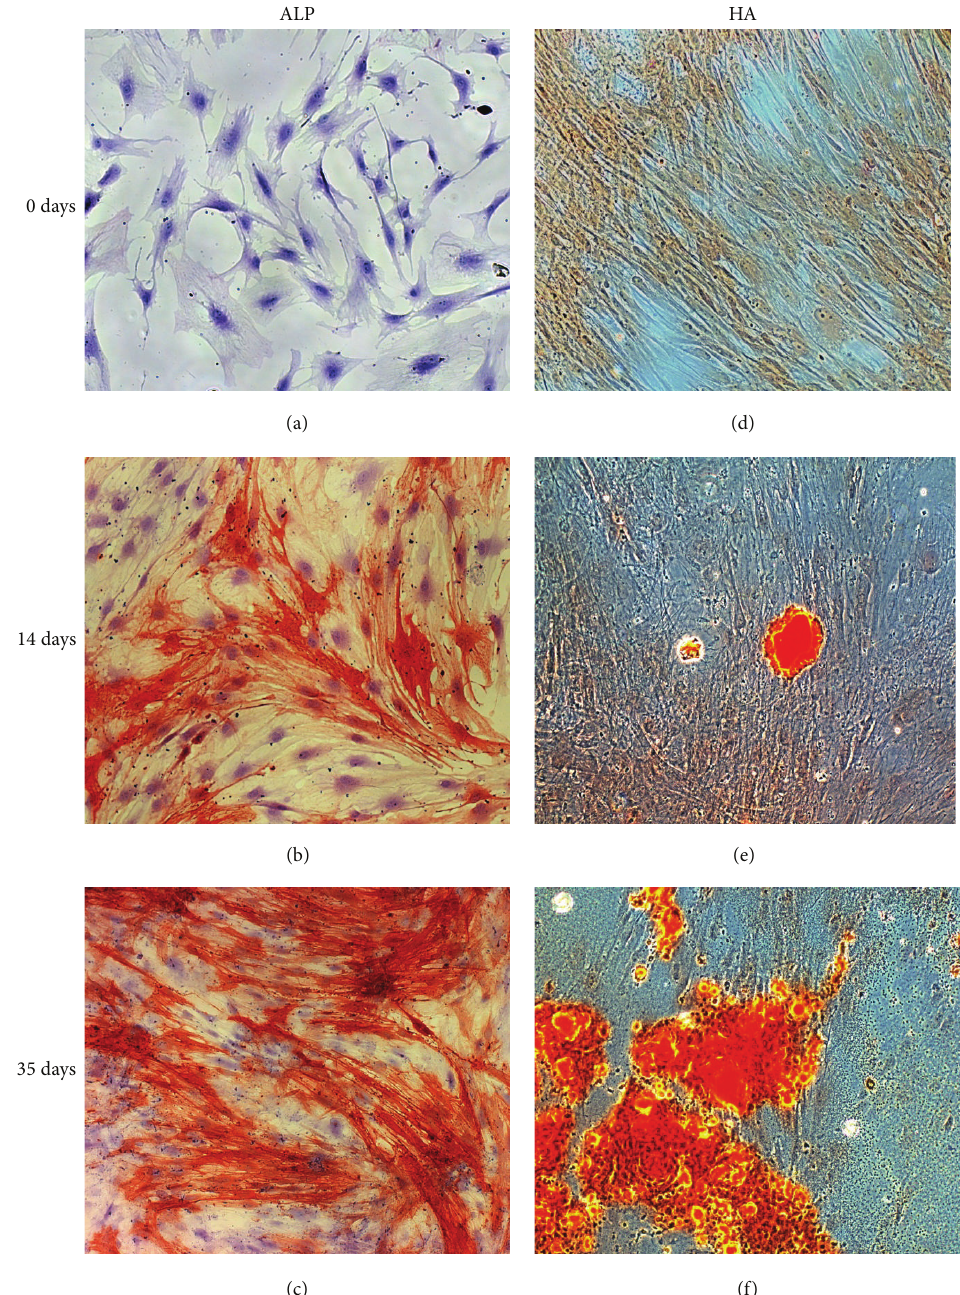
Figure 2: Observation in light microscopy of osteogenic differentiation of the PA20-h5 line at 0 days ((a), (d)), 14 days ((b), (e)), and 35 days of induction ((c), (f)). Cytochemical staining for ALP ((a), (b), and (c)): positive cells stained in red and nuclei counterstained in blue (observation in brightfield microscopy, 20x objective). Cytochemical staining for calcium mineralized deposits ((d), (e), and (f)): deposits stained in red-orange (observation in phase contrast microscopy, 20x